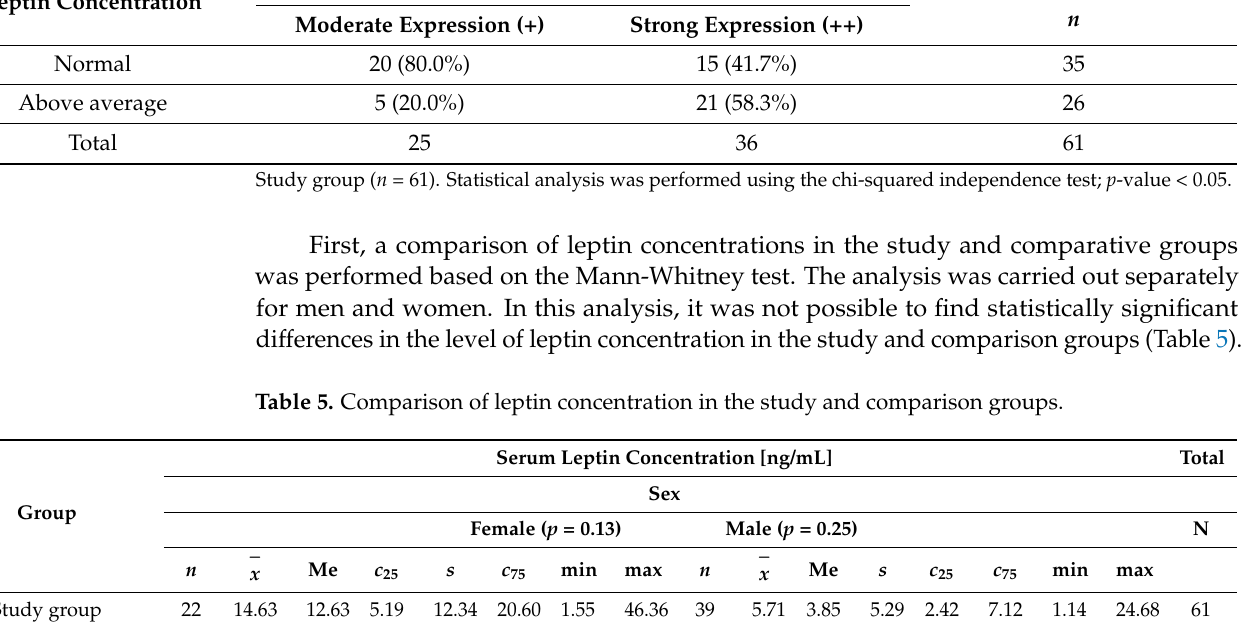
Table 4. Effect of leptin receptor expression on leptin concentration. Leptin Receptor Expression ( p = 0.00) Leptin Concentration